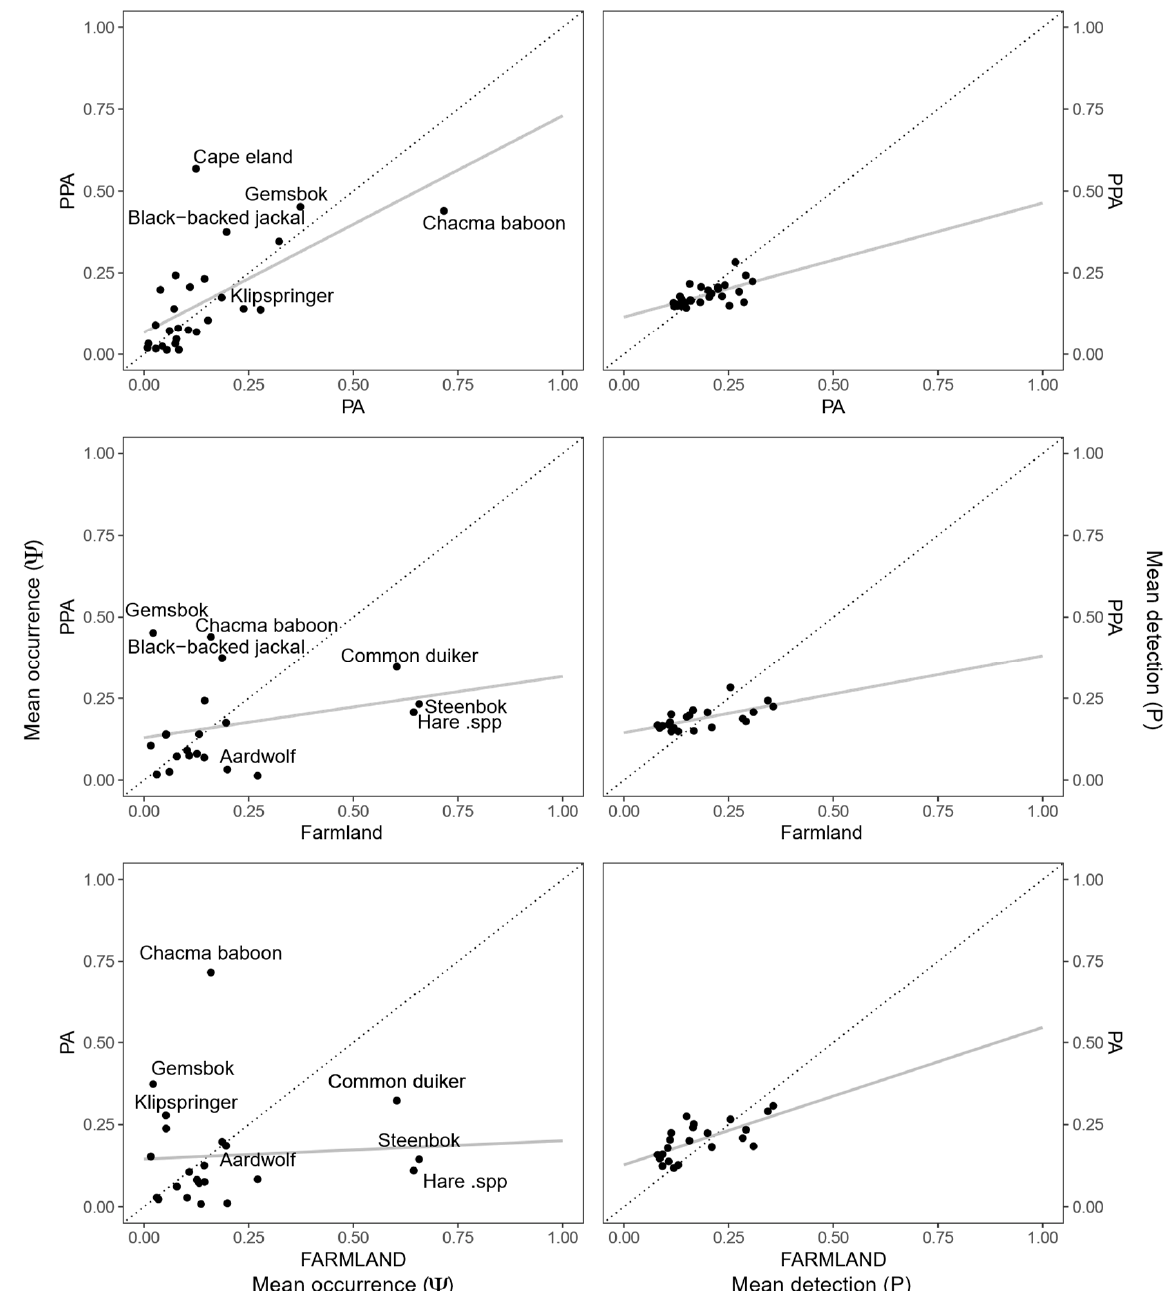
Figure 4. Species-specific mean occurrence ( left ) and detection ( right ) probabilities of mammal species between the small-livestock farmland (Farmland), protected area (PA), and private protected area (PPA). Species not found in any of the land-uses were excluded. Solid grey lines illustrate the regression line for each relationship, and the dotted black line the 1–1 line. Species with notably higher occurrence (>0.25) on the Y or X axis are labelled. Table 1. Mean and associated 95% Bayesian credible intervals (BCIs) of community-level hyper- parameters hypothesised to influence the probability of use and detection of mammal species (>0.5 kg) across three land-uses (farmland, PA and PPA). Bold denotes covariates with significant effects. Parameters include distance to drainage line (m), vegetation productivity (MSAVI2) and terrain ruggedness (TRI) on the occurrence probability, and MSAVI2 on the detection probability.